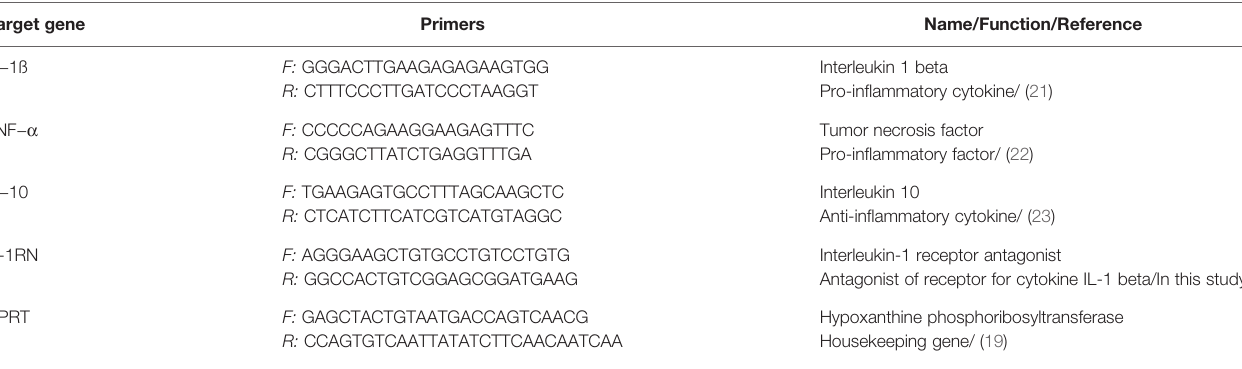
TABLE 1 | Primers used for the real-time PCR quanti fi cation of IL-1ß, TNF − a , IL-10, IL-1RN and HPRT. Target gene